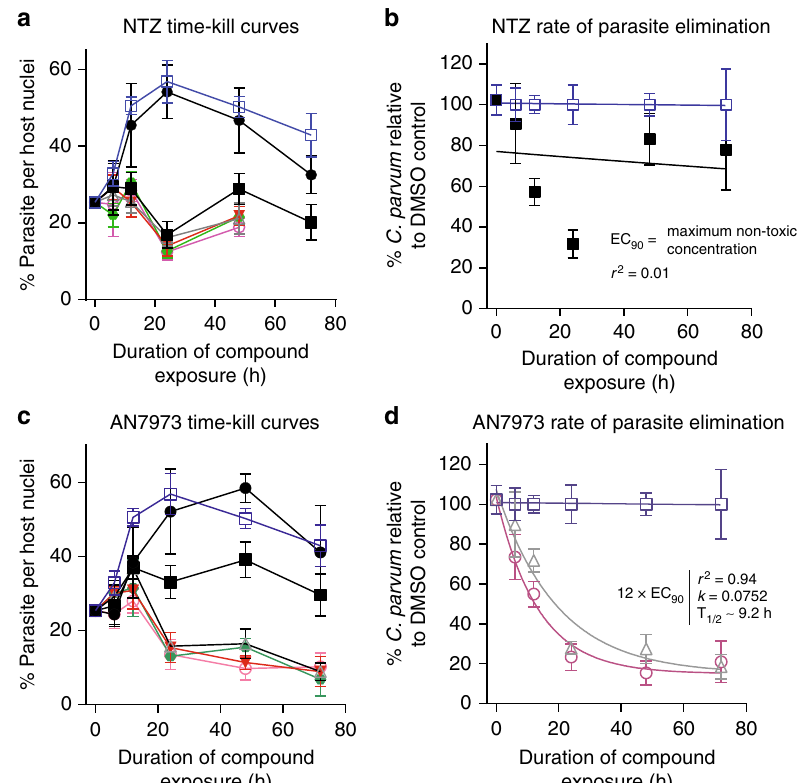
Fig. 3 AN7973 acts rapidly to eliminate Cryptosporidium in vitro. Time-kill curves showing in vitro effects of nitazoxanide (NTZ) or AN7973 on C. parvum (Bunch Grass Farms Iowa isolate) following compound exposure. NTZ or AN7973 were added at varying concentrations ~24 h after infecting HCT-8 cell monolayers, and then parasites were stained and enumerated by high-content microscopy at the indicated time points. Different compound concentrations are indicated in all graphs as follows: open blue squares and blue lines (DMSO control); solid black circles and black lines (EC 50 ); solid black squares and black lines (EC 90 ); open gray triangles and gray lines (3 × EC 90 ); solid red triangles and red lines (6 × EC 90 ); solid green hexagons and green lines (9 × EC 90 ); and open cyan circles and lines (12 × EC 90 ). a and c Percentage of host cells infected vs. time for NTZ and AN7973, respectively. Data shown are the means and SD for 4 culture wells per data point and are representative of 4 independent experiments. b and d One-phase exponential decay curves fi t for the highest non-cytotoxic concentration of NTZ and AN7973, respectively. b No exponential decay curve can be fi t for NTZ. d Rapid parasite elimination by AN7973. Curves shown are for 3 × EC 90 (0.63 µ M), 12 × EC 90 (2.5 µ M) or the DMSO control. For both b and d , the data are referenced to the DMSO control at each time point, in order to isolate the effect of compounds from the spontaneous decline in parasite numbers that occurs in this C. parvum culture system. Data points are the means and SD for 4 culture wells per time point and are representative of 4 independent